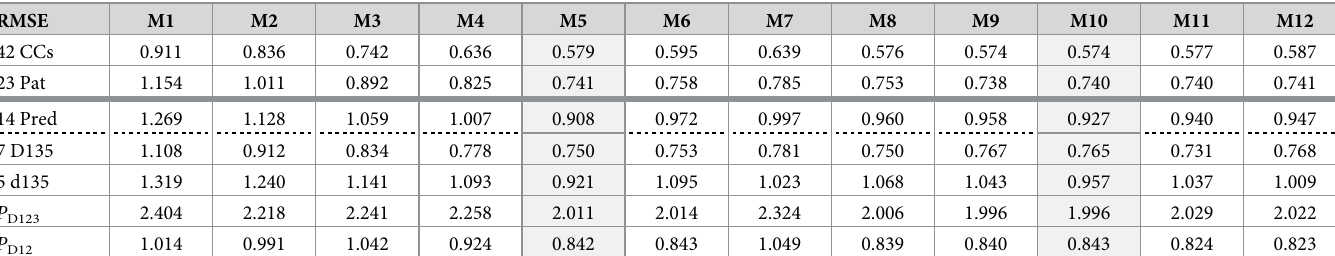
Table 3. Root mean squared error (RMSE) values for the models